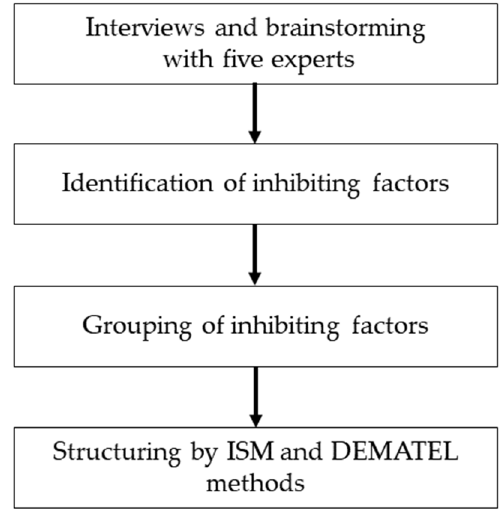
Figure 1. Flowchart of the analysis steps.